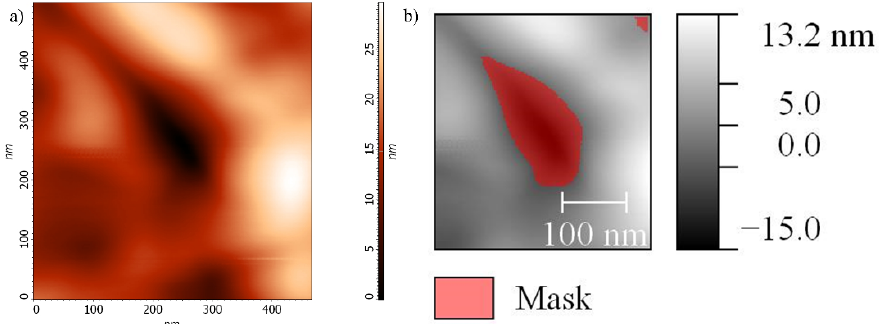
Figure 2. Semi-contact AFM image of an indent on PEN surface ( a ); same image as in the upper panel after cropping and analysis with the software Gwyddion ( b ).